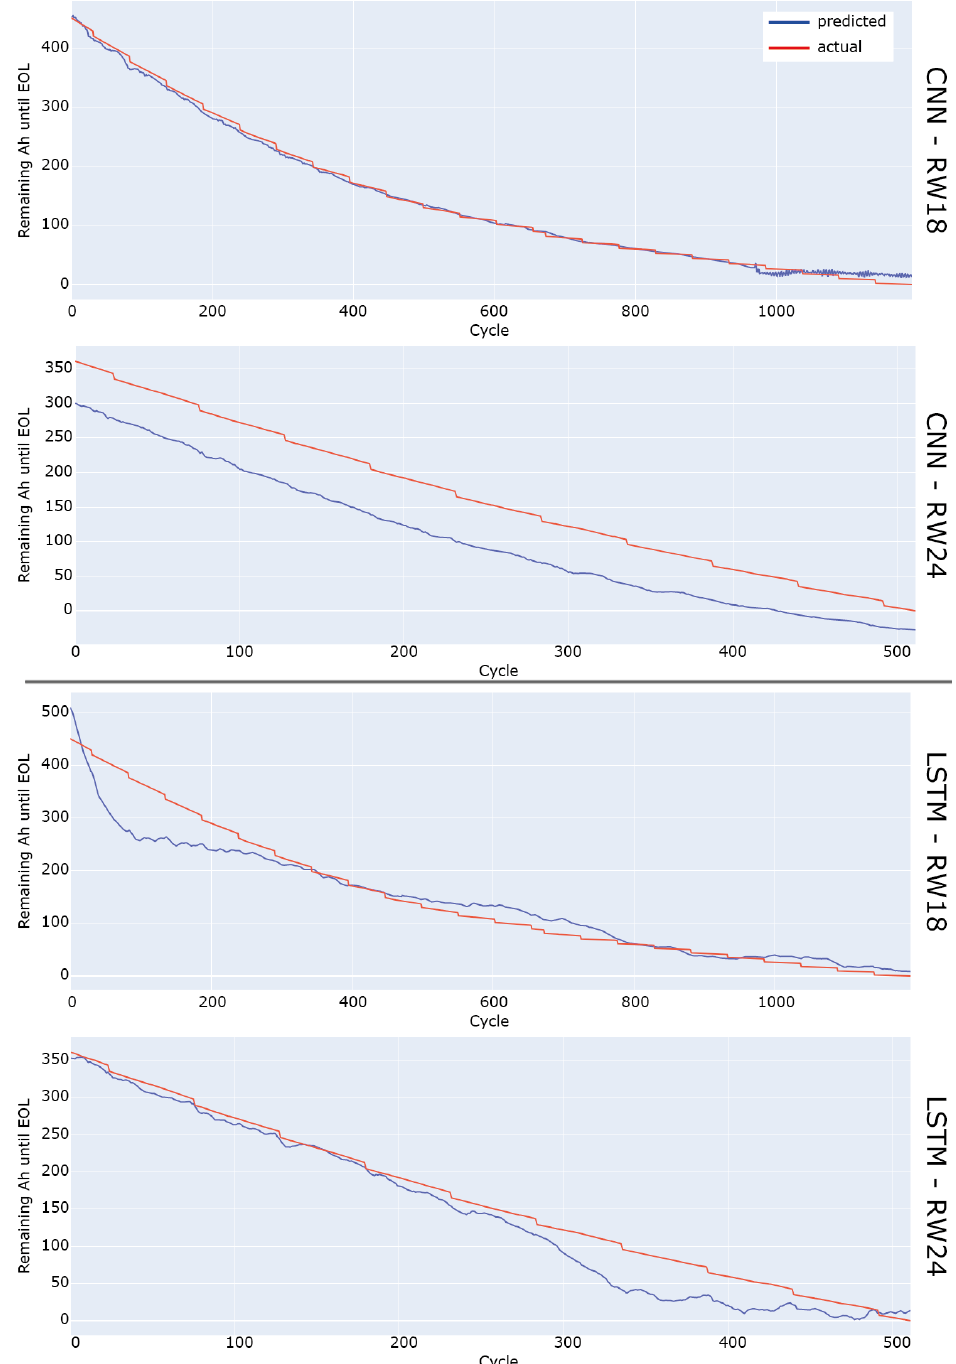
Figure 4. A side-by-side example of the results of the CNN and the LSTM in ah-RUL prediction on the NASA Randomized dataset. The two examples show better stability and curve fitting of the CNN but a lower offset from the